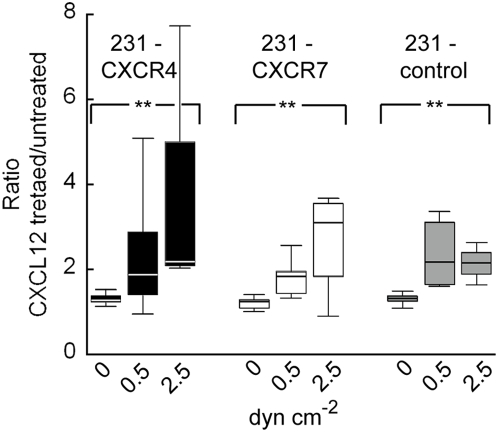
Adhesion selectivity of cancer cells onto the CXCL12 treated endothelial region over the untreated region at different flow conditions.The boxplots were grouped together by cancer cell type at 0 (or static), 0.50, and 2.50 dyn cm−2 flow conditions. For each cell type, the adhesion selectivity was statistically different for the different flow conditions (**, p<0.05) with the selectivity consistently increasing from static to flow conditions. n = 4–6 for each condition.